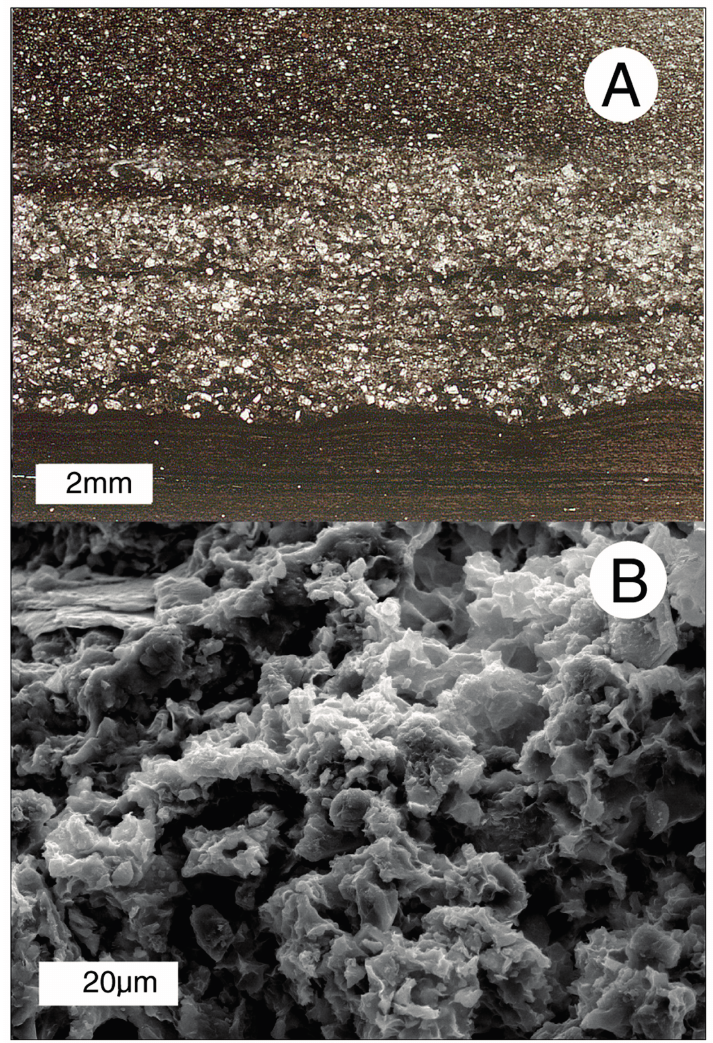
Figure 8. Tephra interbed in siliceous shale: ( A ) Optical photomicrograph shows